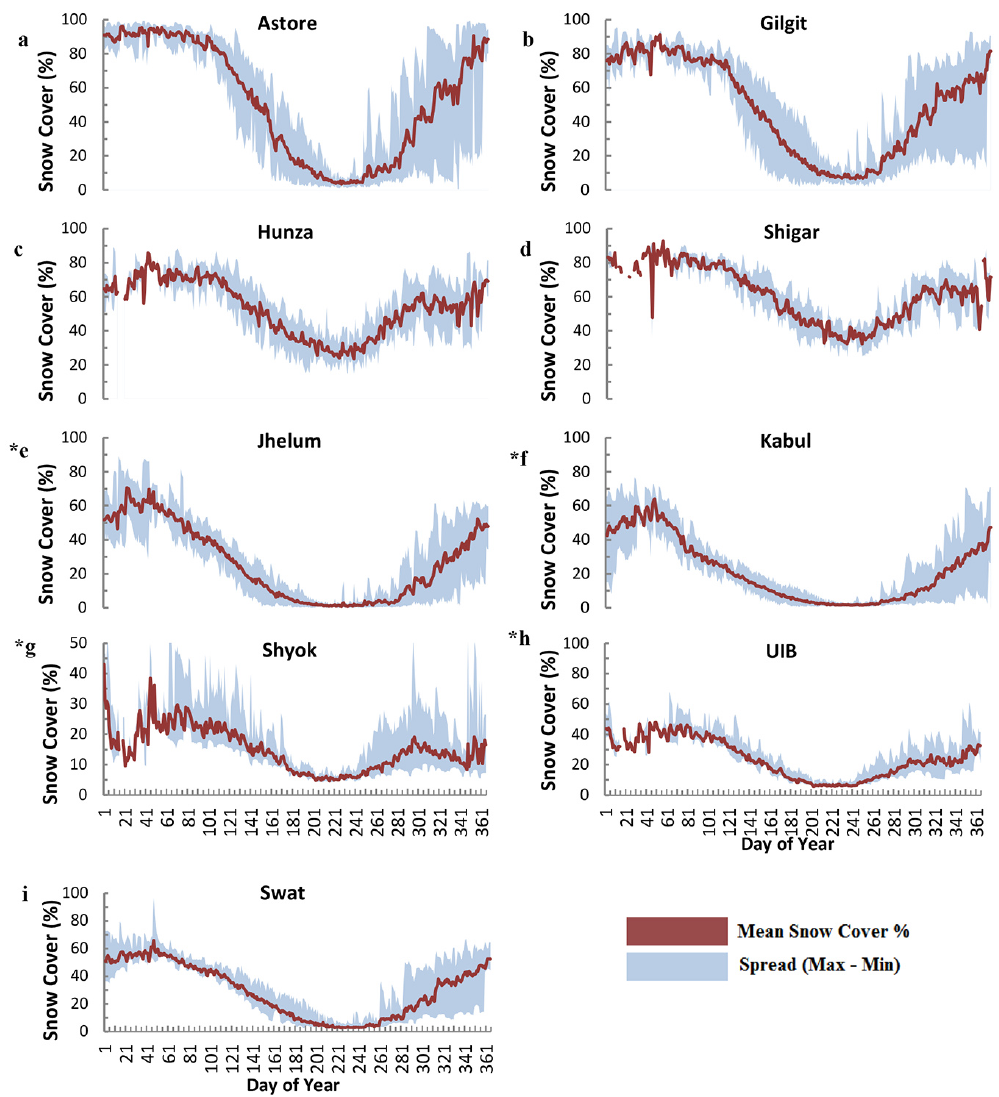
Figure 10. (a–i) : Mean snow cover and its variability over the period 2001–2012 for all basins. The blue shaded area shows the spread (mean minimum and mean maximum), whereas the red line shows the mean of the snow cover percentage over the whole period. Note: (*) indicate major